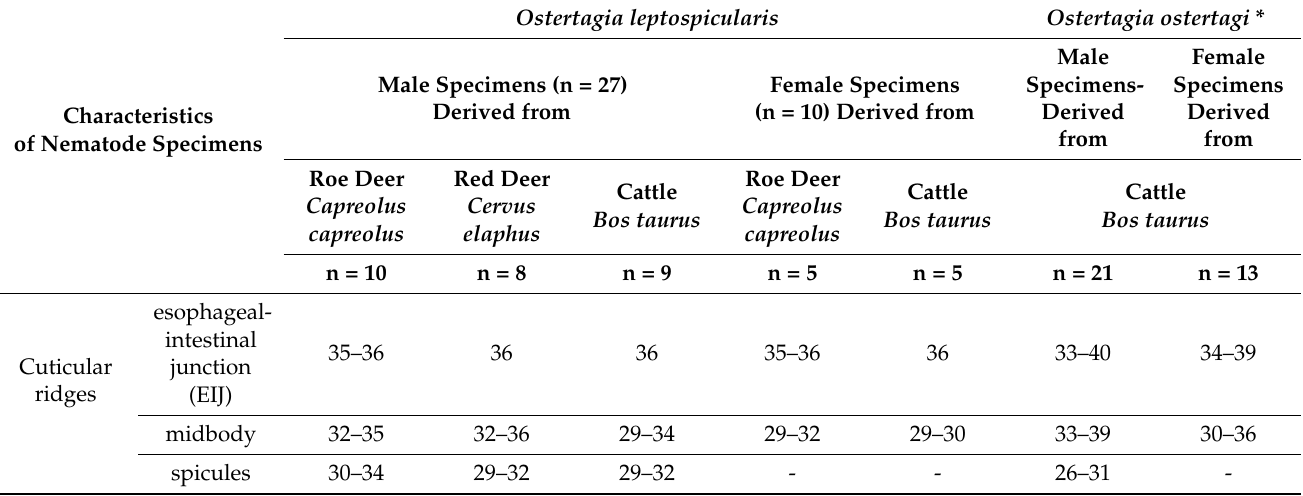
Table 4. Number of longitudinal cuticular ridges of nematodes in relation to host